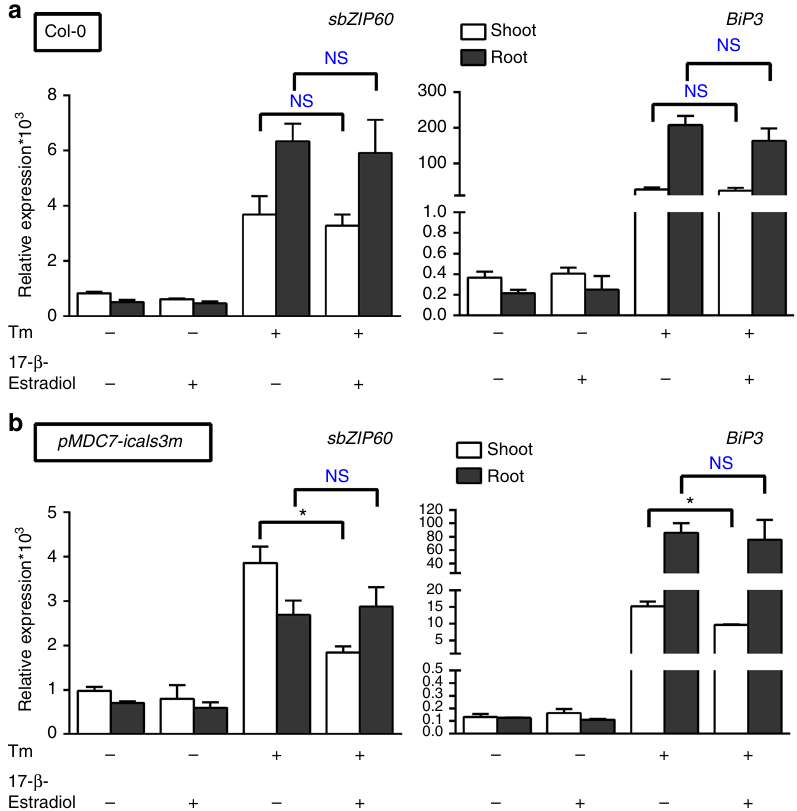
Fig. 5 Long-distance of UPR signaling relies on the PD availability. a , b Quantitative RT-PCR analyses of sbZIP60 and BiP3 in 14-day-old wild type (Col-0) ( a ) and a conditional PD block mutant ( pMDC7-icals3m) ( b ) seedlings treated with DMSO (Mock), 10 μ M 17- β -estradiol (estrogen), 0.5 µ M Tm (Tunicamycin), and 10 μ M 17- β -estradiol (estrogen) in combination with 0.5 µ M Tm (Tunicamycin) at the root in the shoot – root split system for 24 h. Transcription of UBQ10 was used as internal control. Error bars represent s.e.m among three biological replicates. Data signi fi cantly different from the corresponding control are indicated by asterisks (* P < 0.05, NS, nonsigni fi cant; Unpaired t